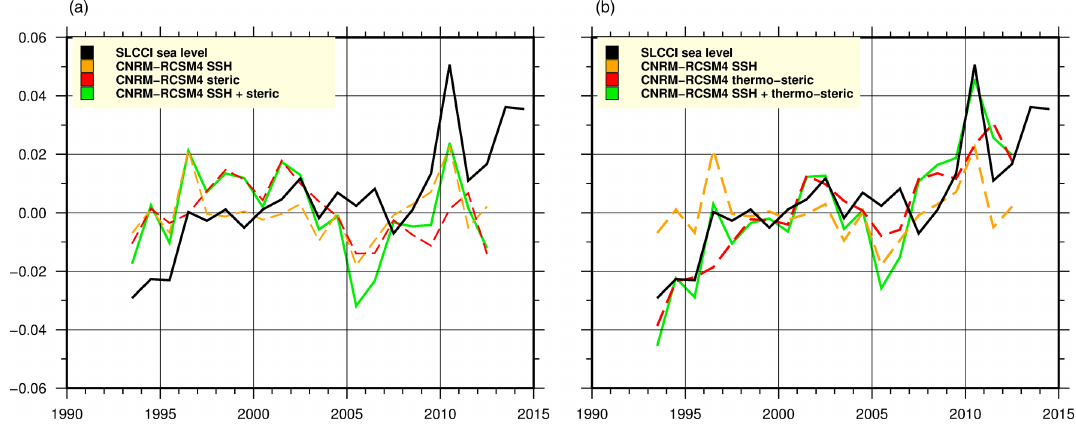
Figure 16. CNRM vs. SL_cci total sea level. (a) Sea surface height (green) from elevation plus steric compared with SL_cci (black), with elevation (orange) and steric (red) components. (b) As in (a) with thermo-steric instead of steric. For both plots, the vertical axis is in metres.